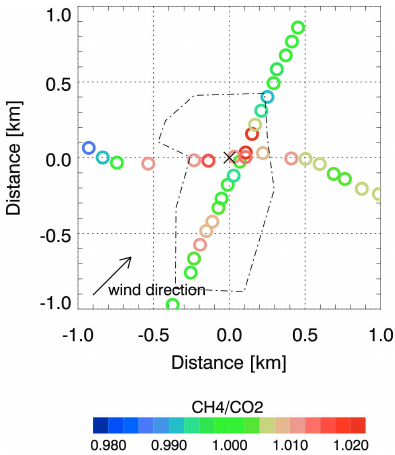
Fig. 14. Normalized CH 4 /CO 2 profile scaling factor ratio (PSFR BM ) showing anomaly in the upper part of the landfill Vor- ketzin located near Berlin in Eastern Germany. Data acquired with MAMAP on 26 July 2007. The data have been smoothed using a three point moving average. Gaps are due to the quality filter- ing: shown are only measurements where the spectral signal was larger than 3000 [ BU ] after dark signal correction and the root- mean-square (RMS) of the fit residuum (relative difference between measurement and model after the fit) is better than 1%. The dashed line shows the landfill body. To remove low frequency variations data were filtered with a 80 point high-pass